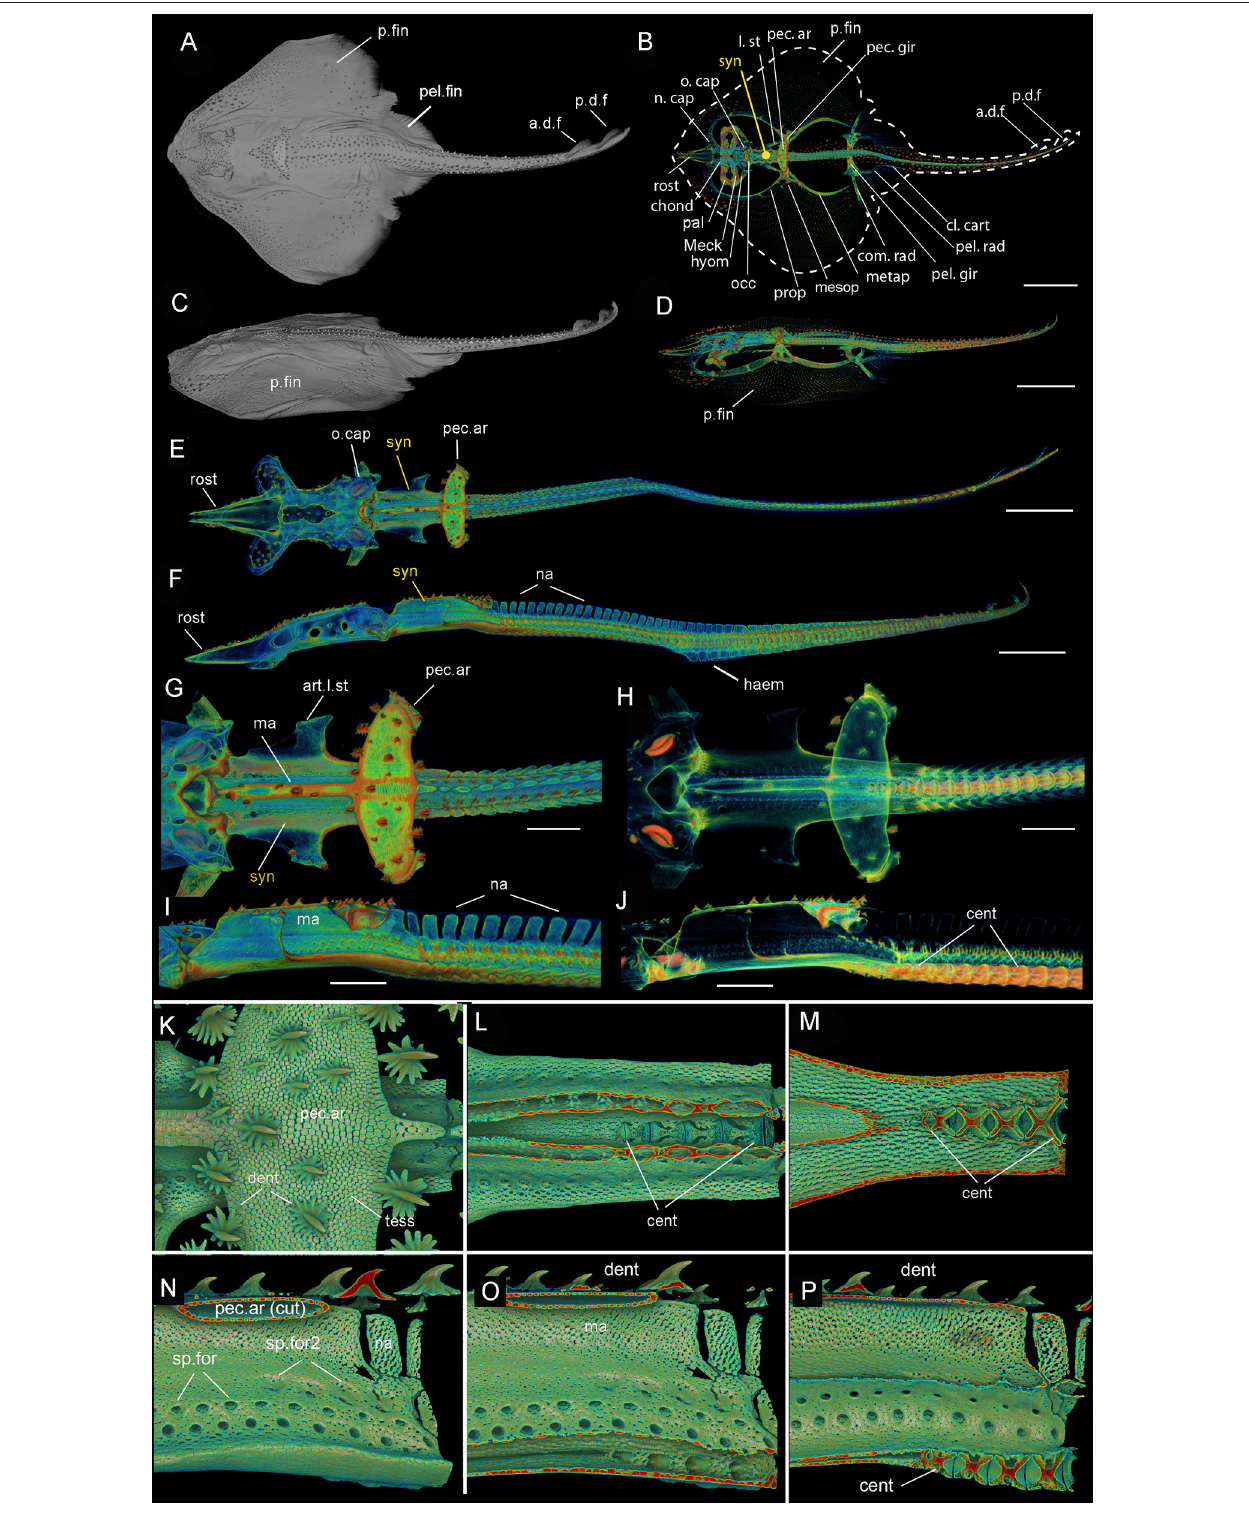
FIGURE 1 | Leucoraja erinacea , adult (BMNH 2018.9.26.1), 3D rendered µ CT scans (A,C–P) , grayscale (A,C), and false colored (D–P) . (A) Dorsal view, (C) lateral view of entire individual; (B) outline of dorsal view showing general morphology; (D) lateral view of entire individual; (E) dorsal view, (F) lateral view, of entire